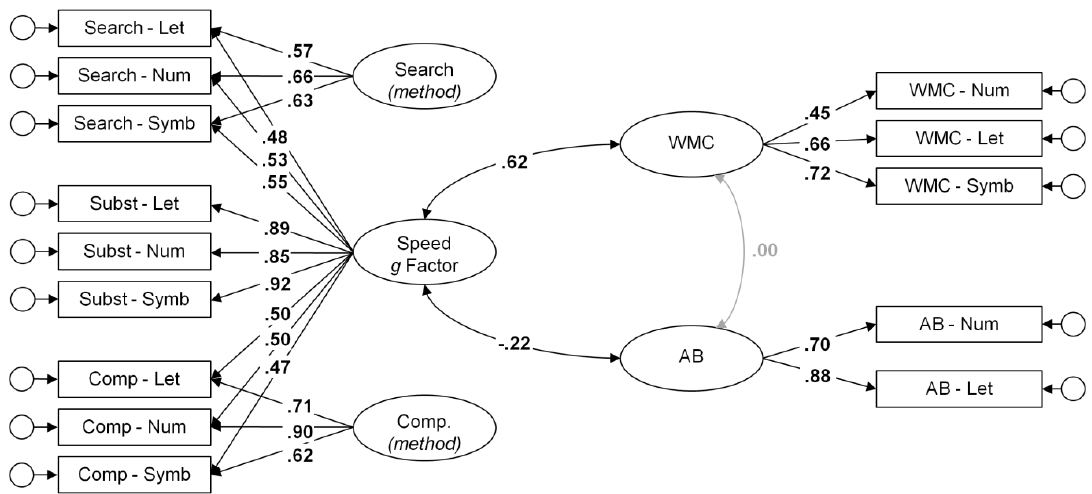
Figure 3. Latent Correlations of a Mental Speed General Factor with WMC and AB.